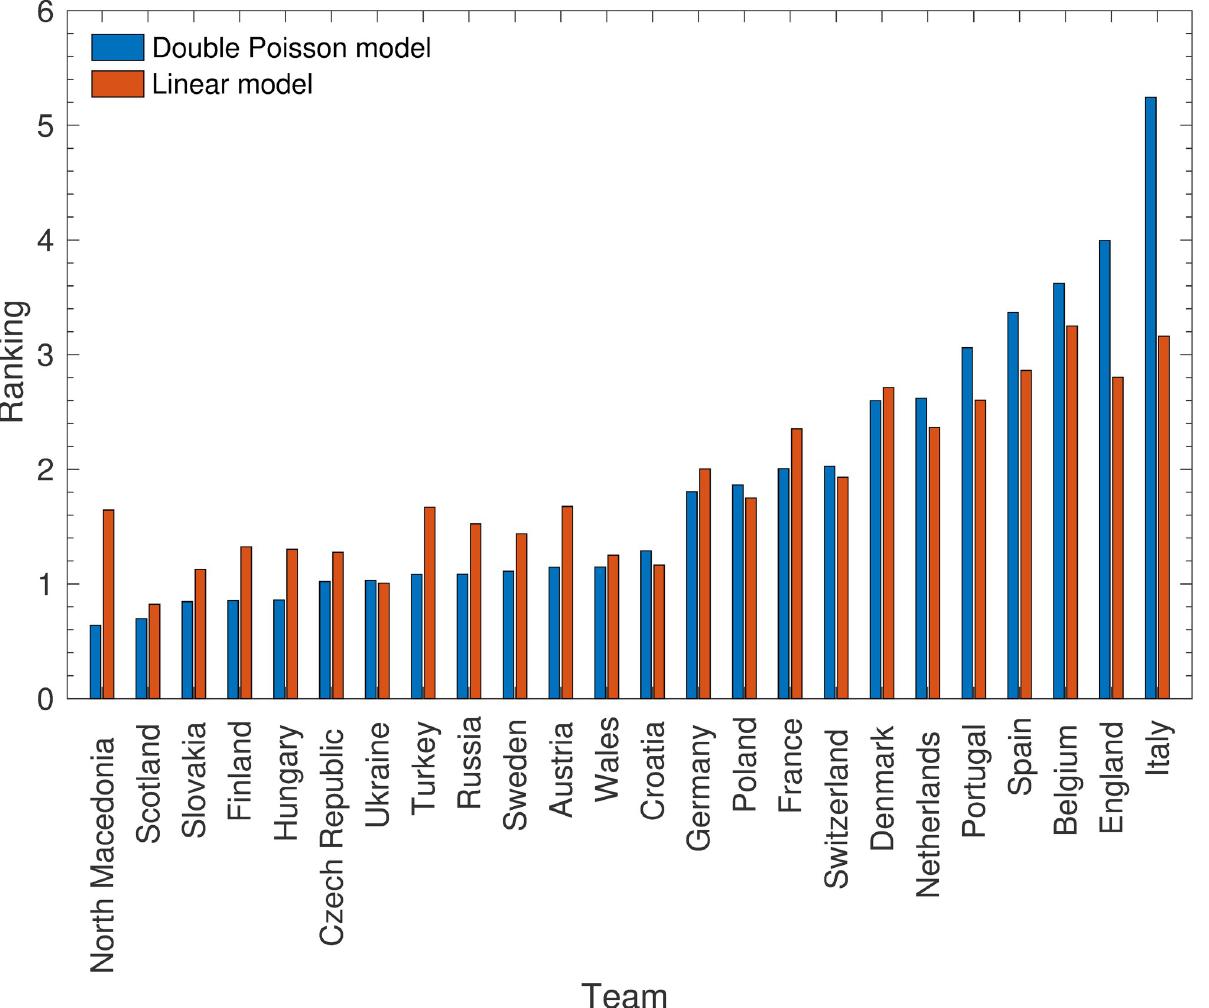
Fig 13. A comparison of team rankings from the double Poisson model and those from the linear model. This shows the rankings that are derived from each model for the 24 teams in Euro 2020. Note that the rankings have been normalised to ensure that they have the same sum, and to allow for easy comparison. This means that the Poisson rankings do not match the parameters considered in previous